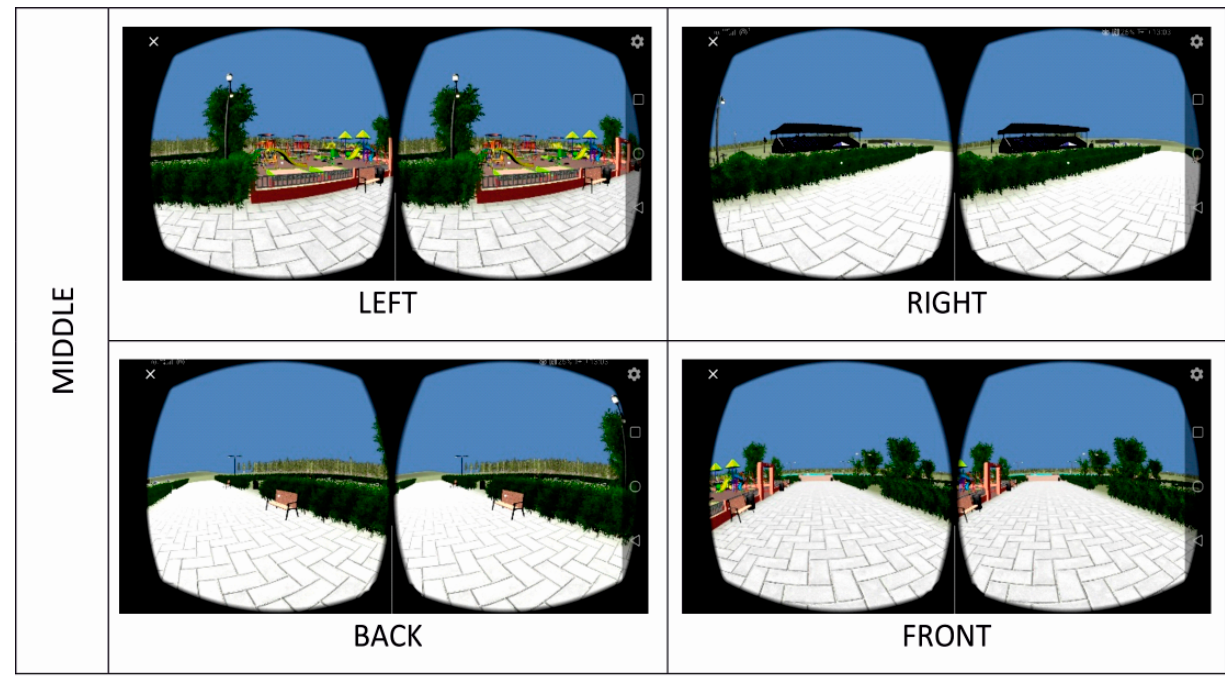
Figure 13. VR views on a mobile device. Source: prepared by the author.